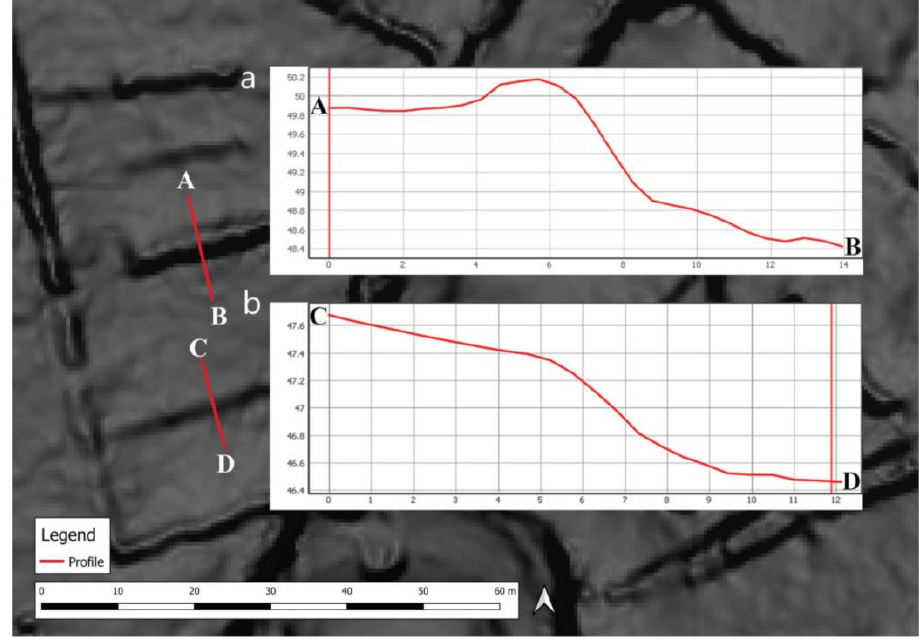
Figure 24. Screenshots of a QGIS session using the profile tool. ( a ) Surface profiles help to distinguish terrace slopes ( b ) from slopes that are overlain by a stone deposit (visualization: